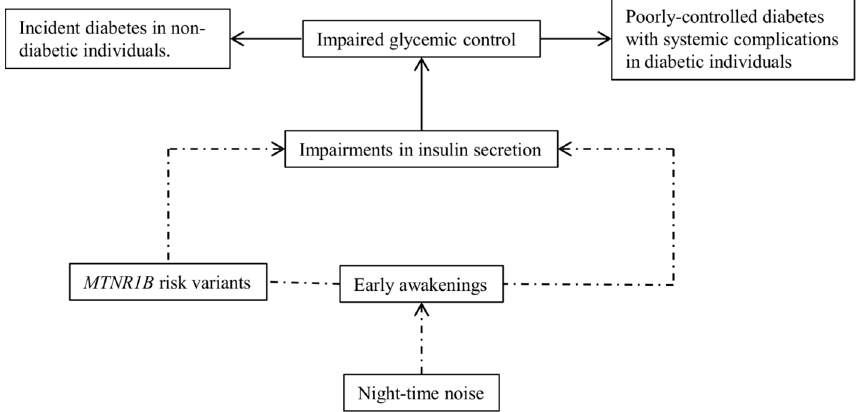
Figure 1. Hypothesized mechanisms of noise effects on glucose homeostasis explored in the present study.